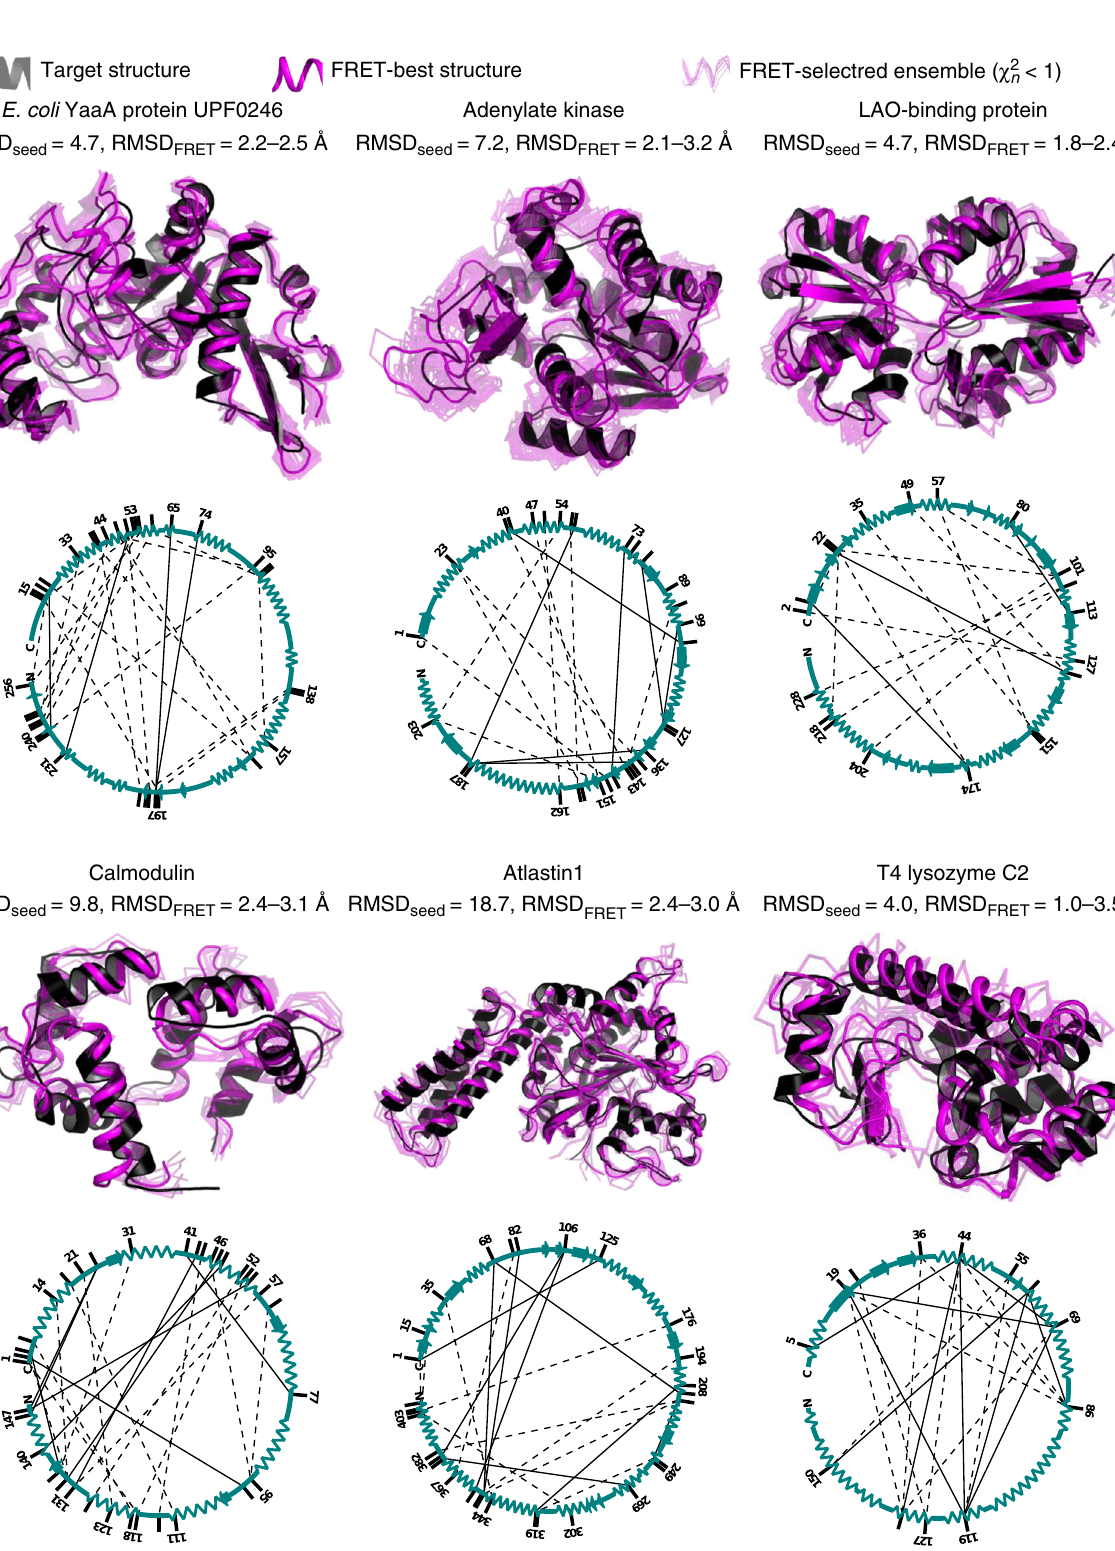
Fig. 4 Accuracy and uncertainty of FRET-assisted structure models. Structures obtained by FRET-assisted modeling (magenta) and target X-ray structures (black) are shown for each of the benchmarked proteins. FRET-selected structures are depicted in transparent magenta as a measure for uncertainty; a con fi dence level of 68% is assumed. RMSD of C α atoms of the seed conformer (RMSD seed ) and FRET-selected conformers (RMSD FRET ) against the target crystal structure is shown below the protein name. Networks of FRET pairs and secondary structures of corresponding seed conformers (cyan) are shown below the selected